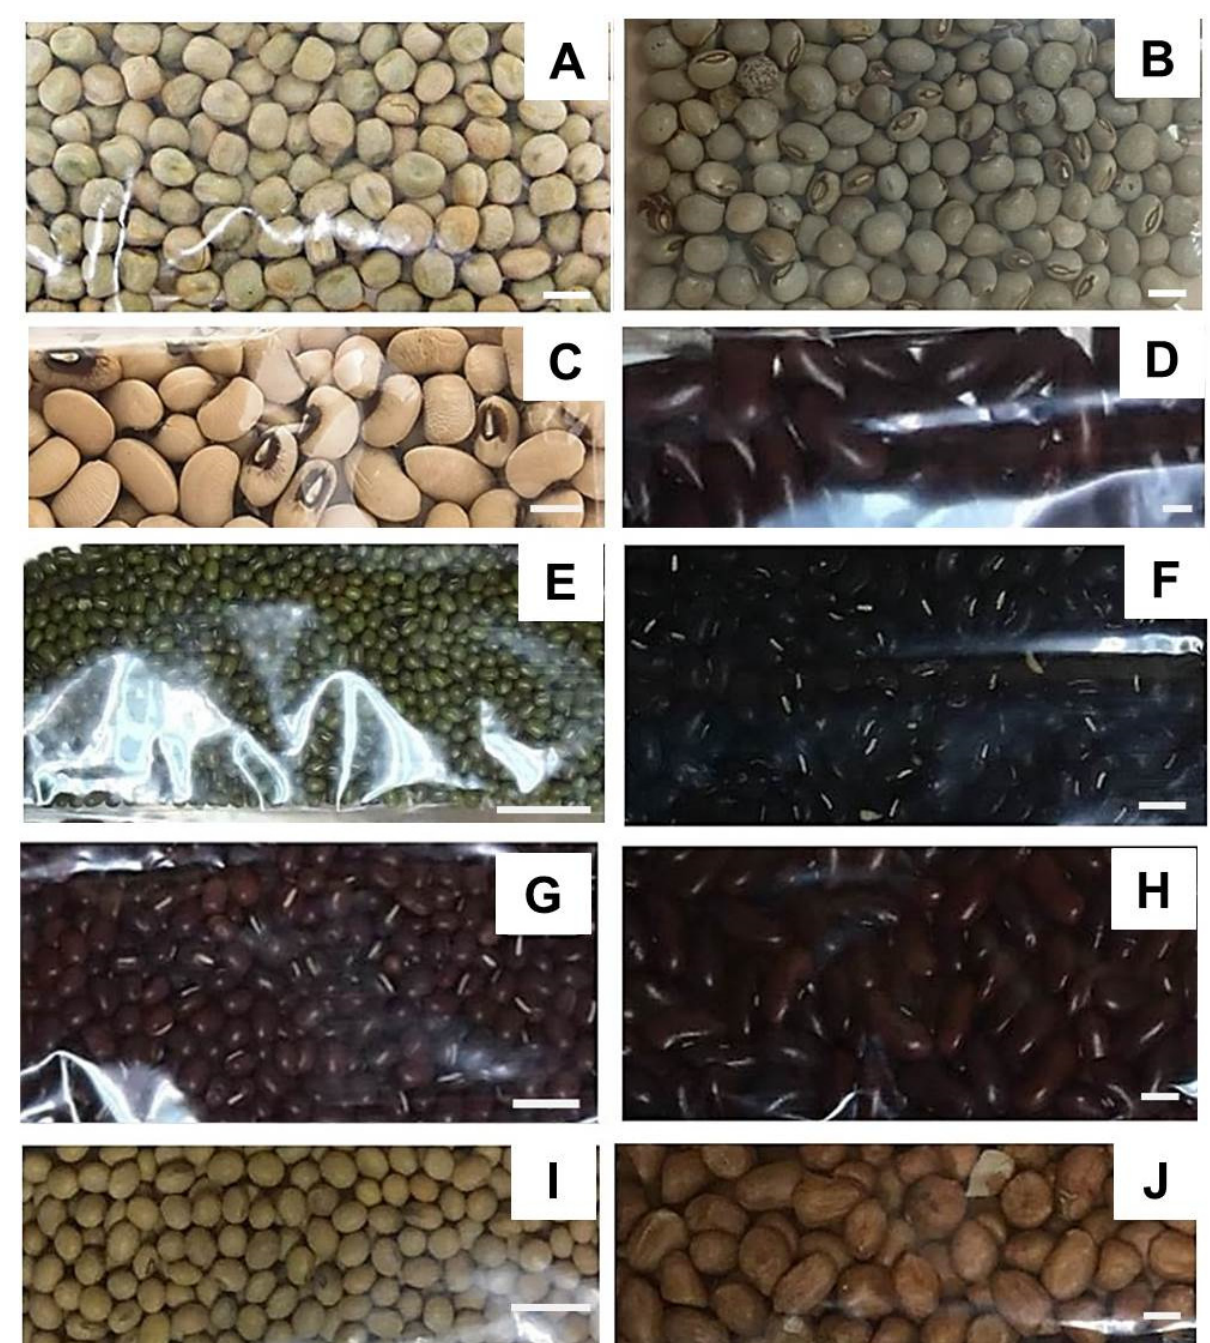
Figure 1. The collected seeds of Fabaceae plant in Thailand: ( A ) P . sativum , ( B ) C . cajan , ( C ) V . unguiculate ., ( D ) V . unguiculata subsp. sesquipedalis , ( E ) V . radiata , ( F ) V . mungo , ( G ) V . angularis , ( H ) P . vulgaris , ( I ) G . max , ( J ) A . hypogaea ; Bar scale = 1 cm. The photos were taken in Thailand by D.T. Table 1. Evolution of total phenolic content (TPC), total flavonoid content (TFC) and monomeric anthocyanin content (MAC) before (uncooked), and after traditional cooking (cooked) and after tra- ditional cooking followed by in vitro gastro-intestinal digestion (in vitro Digestion) from beans from ten Fabaceae species.